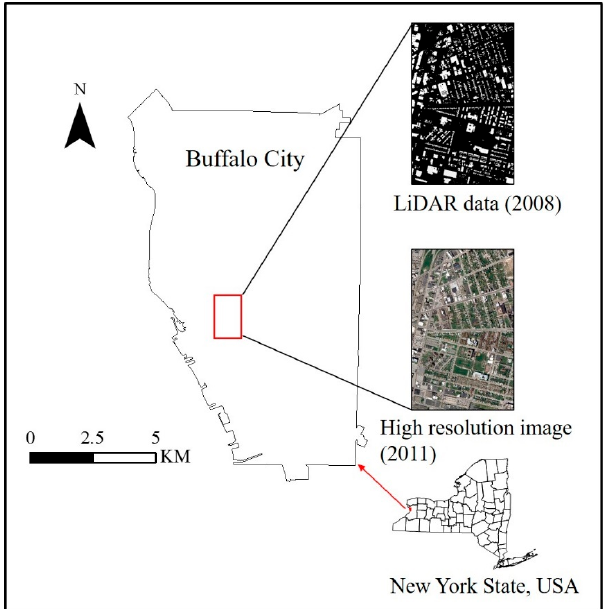
Figure 1. Study site: Buffalo, NY, USA.